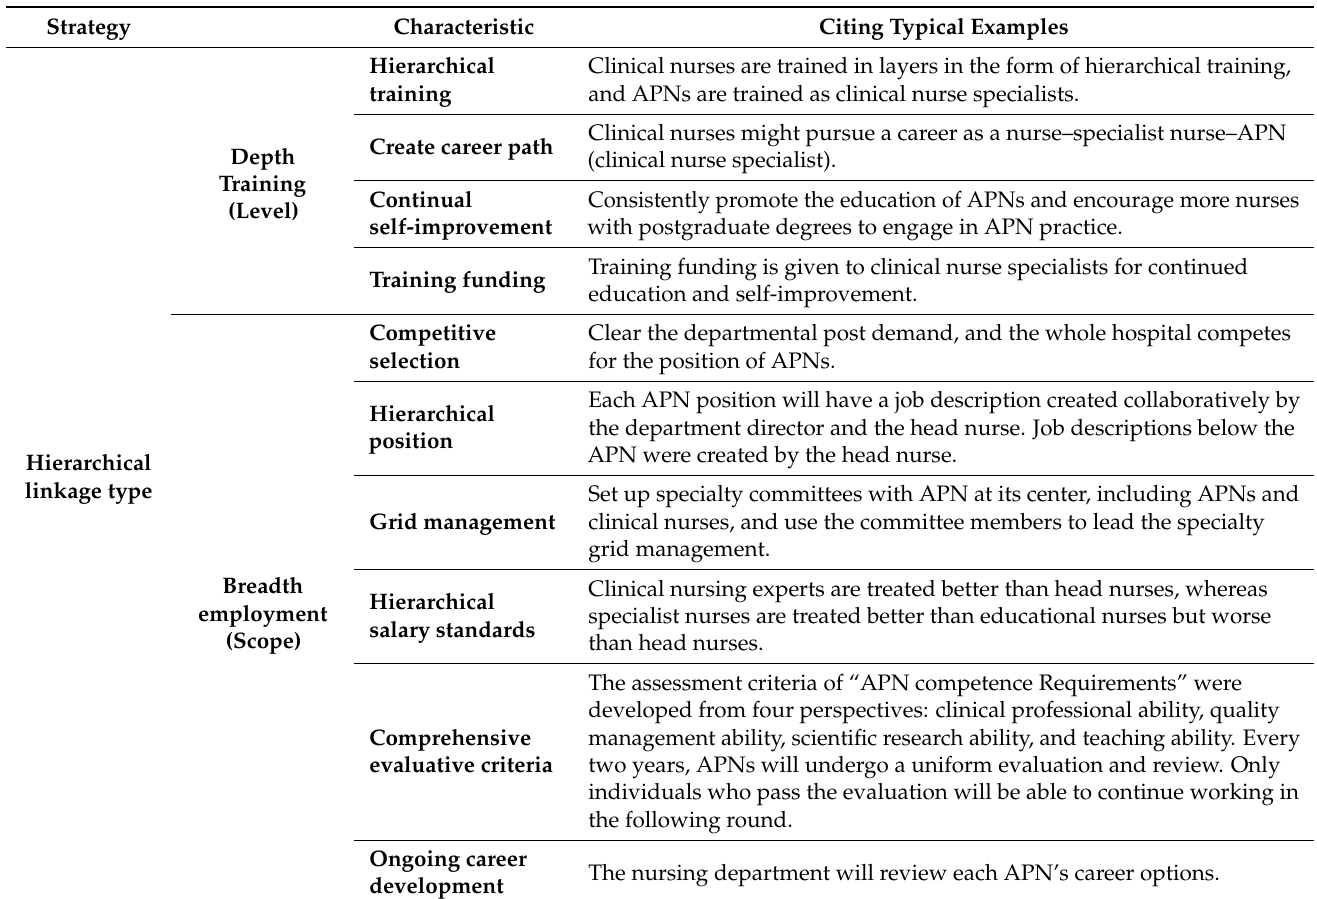
Table 5. Typical examples of management strategies of hierarchical linkage